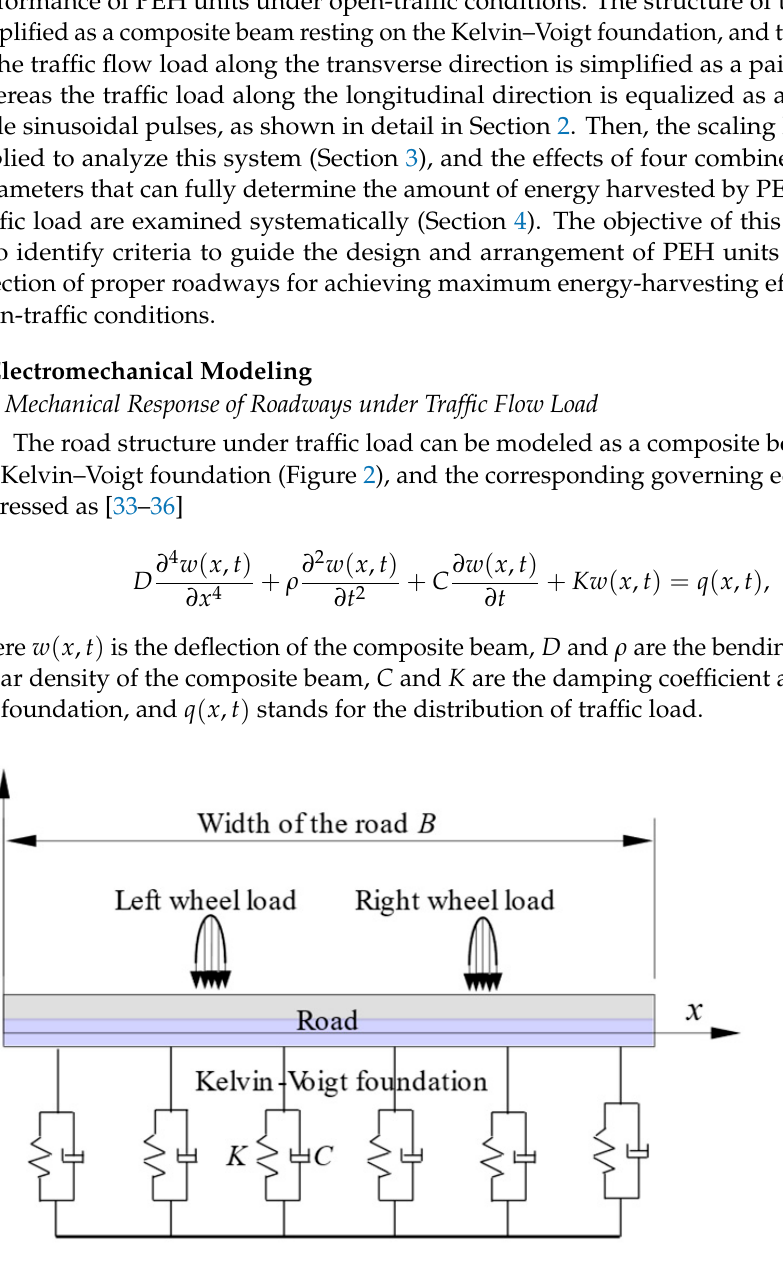
Figure 2. Schematic illustration of the road under traffic load.